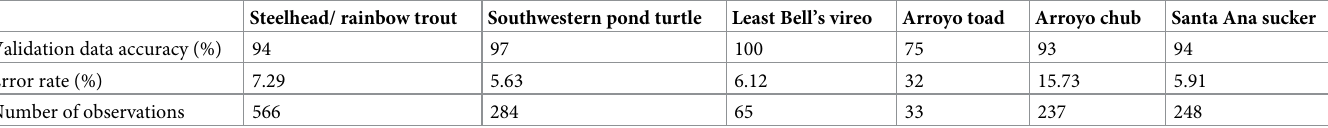
Table 2. Performance of the random forest model that used the streamflow metrics to predict species distribution.